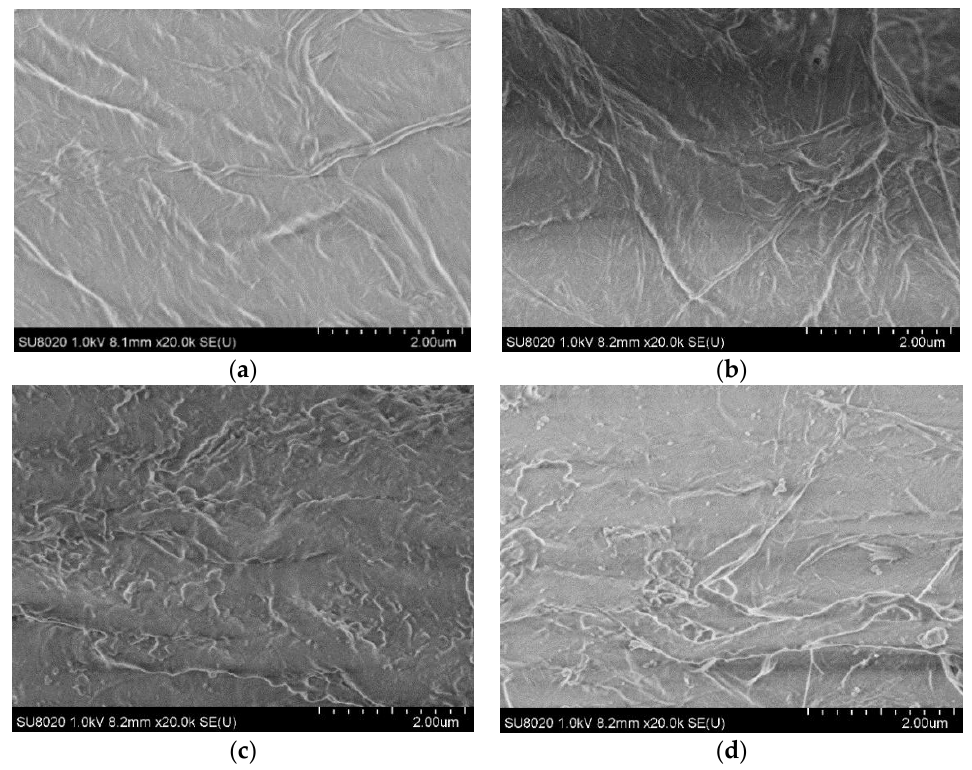
Figure 2. Representative scanning electron microscopy (SEM) images of ( a ) neat pressboard and montmorillonite (MMT)/pressboard nanocomposites filled with ( b ) 1 wt %, ( c ) 2.5 wt %, and ( d ) 5.0 wt % nano-MMT.